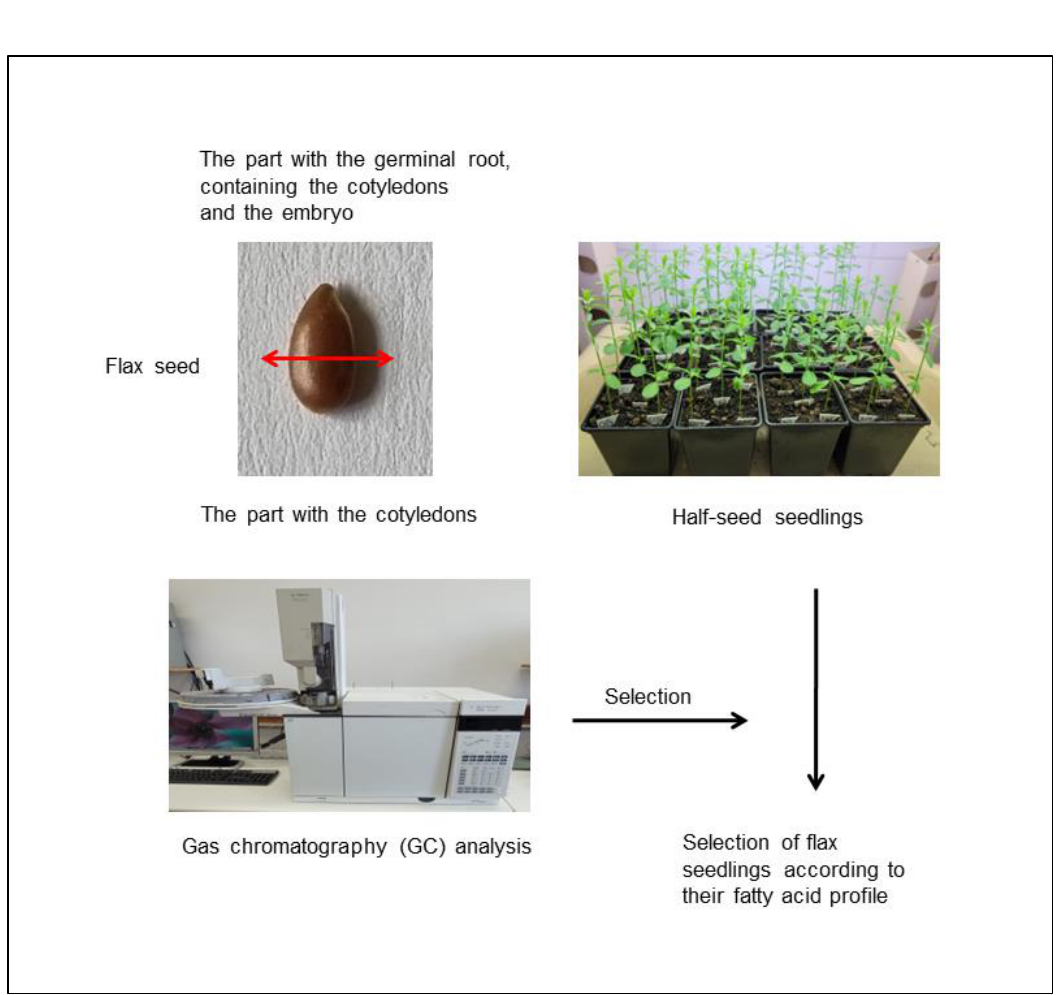
Figure 1. Diagram of the half-seed method — recreated based on the figure presented by Jousse et al. [16].